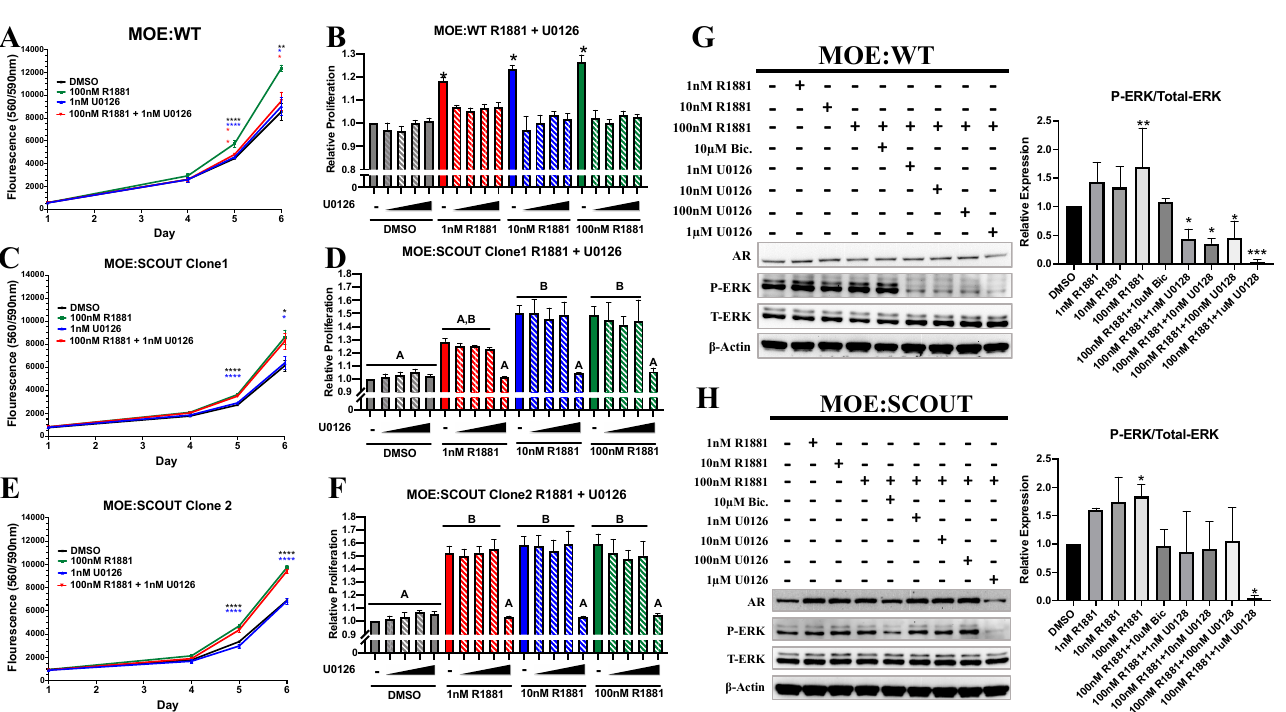
Figure 3. Androgens mediated proliferation is dependent on presence of phospho-ERK. ( A , C , E ) Cellular viability was measured by CellTiter Blue assay after exposure to DMSO, 100 nM R1881, 1 nM U0126, or a combination for 4, 5, and 6 days (each day was individually analyzed using a one-way ANOVA followed by a Dunnett’s post hoc, n ≥ 4, Significant differences from control are represented by * p < 0.05, ** p < 0.01, *** p < 0.001, **** p < 0.0001). ( B , D , F ) Cells were cultured in various concentrations of R1881 (0 nM, 1 nM, 10 nM, and 100 nM, respectively) and U0126 (0 nM, 1 nM, 10 nM, 100 nM, and 1 µ M respectively) for 5 days. Relative proliferation was measured via Sulforhodamine B (SRB) assay ( n ≥ 3, one-way ANOVA followed by a Tukey’s post-hoc, letters above bars indicate differences between groups at p < 0.05). ( G , H ) Western blots and relative densitometry for MOE:WT and MOE:SCOUT clones cultured in steroid free media for 24 h followed by treatment with various concentrations of R1881 and U0126 for 24 h.